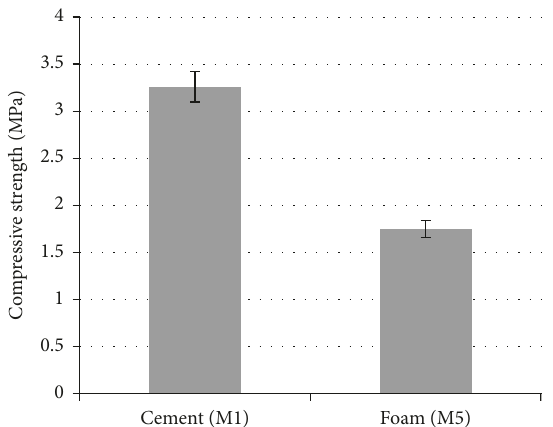
Figure 10: Compressive strength of geopolymer materials activated with 8M of